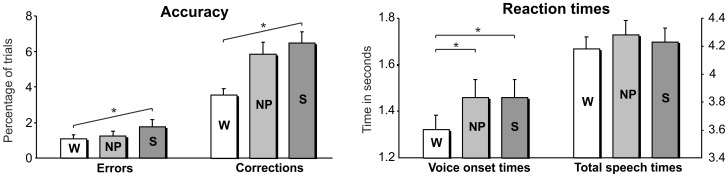
Behavioural data.Mean accuracy (left panel) and reaction times (right panel) per condition. Reaction times (plus standard errors) are displayed for voice onset times (VOT; left axis) and for total speech times (TST; right axis). Asterisks indicate significant linear trends (observed for accuracy) or significant contrasts (observed for VOT). ‘W’ = minimal syntax, word condition, ‘NP’ = noun phrase-level syntax condition, ‘S’ = sentence-level syntax condition.